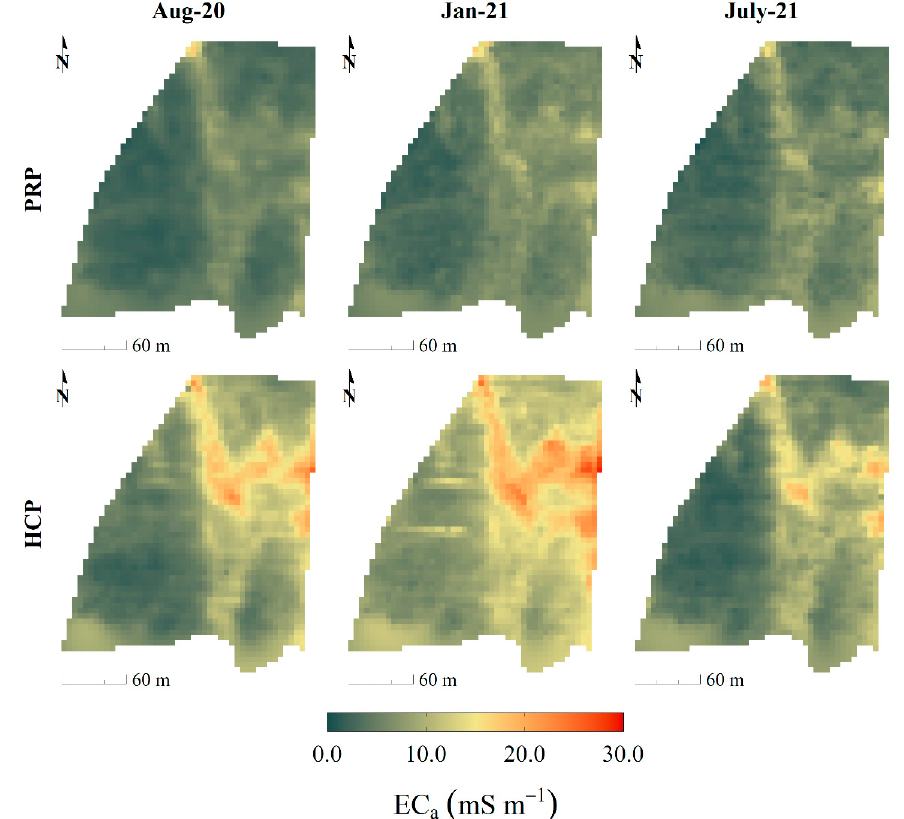
Figure 4. Spatial distribution of the universally kriged, perpendicular geometry (PRP) and horizontal coplanar geometry (HCP) apparent electrical conductivity (EC a ) for the first (August-20), middle (January-21), and last (July-21) of the 12 monthly EC a surveys conducted between 2020 and 2021 at the agroforestry site in Fayetteville, AR. Maps were created in R Studio (version 4.05, R Core Team, Boston, MA, USA).